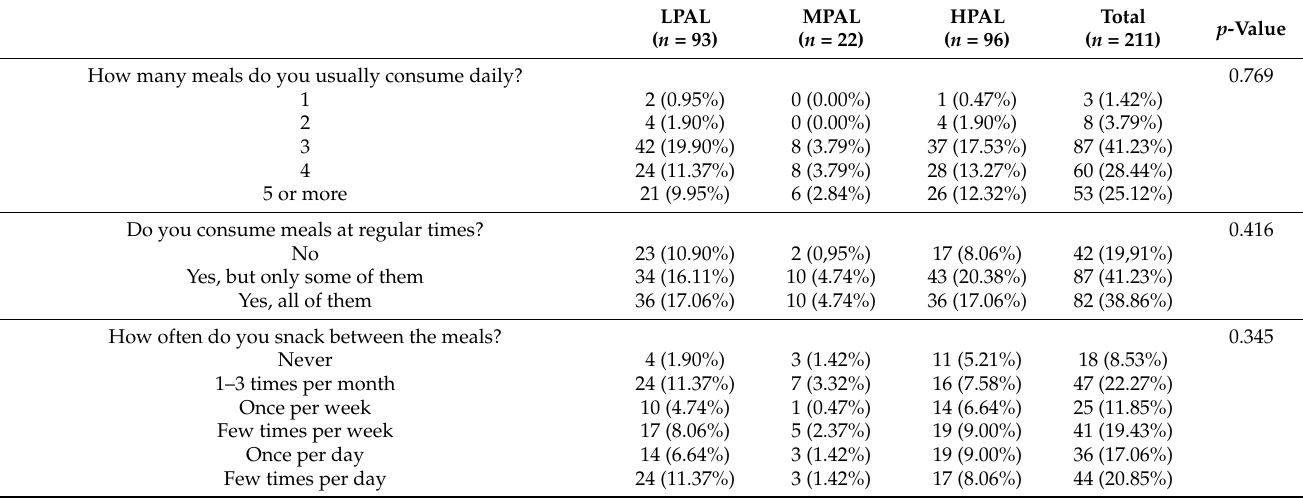
Table 2. Dietary habits of prisoners by physical activity